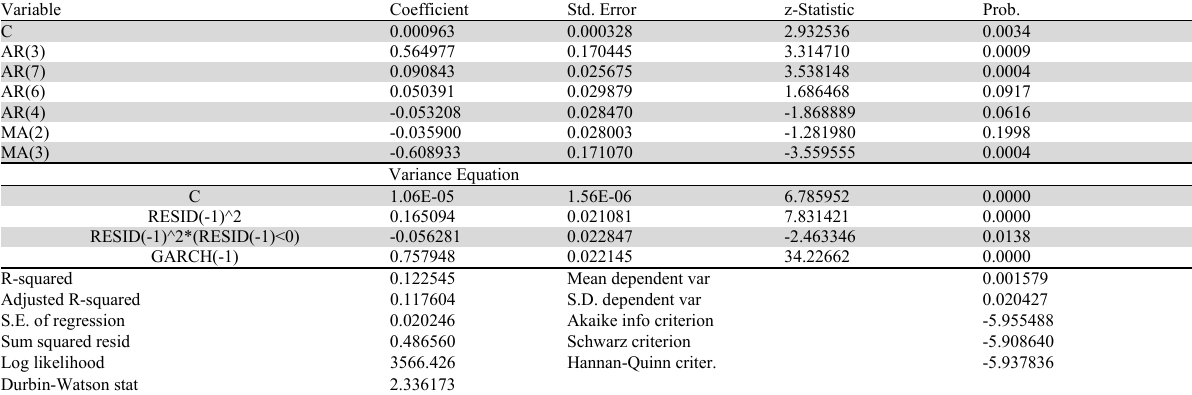
The results of TARCH model on gold price